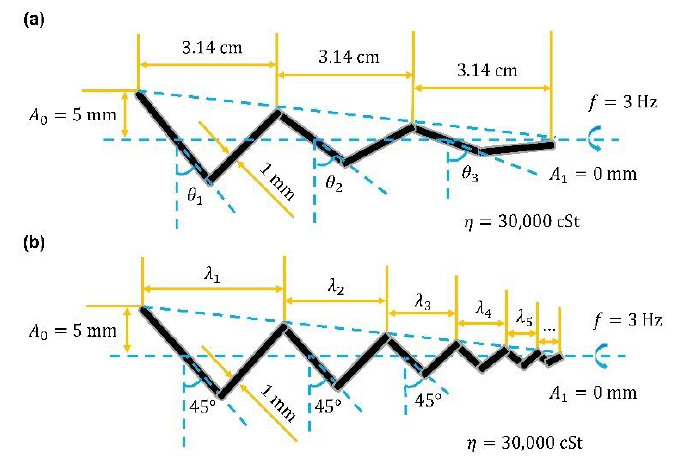
Figure 5. Two types of tapered helical swimmers. ( a ) The tapered helical swimmer with a constant pitch. ( b ) The tapered helical swimmer with a constant helix angle. Some main parameters are the same as the basic model (i.e., d = 0.5 mm, λ = 3.14 cm, 𝜂 = 30,000 cSt, and f = 3 Hz).